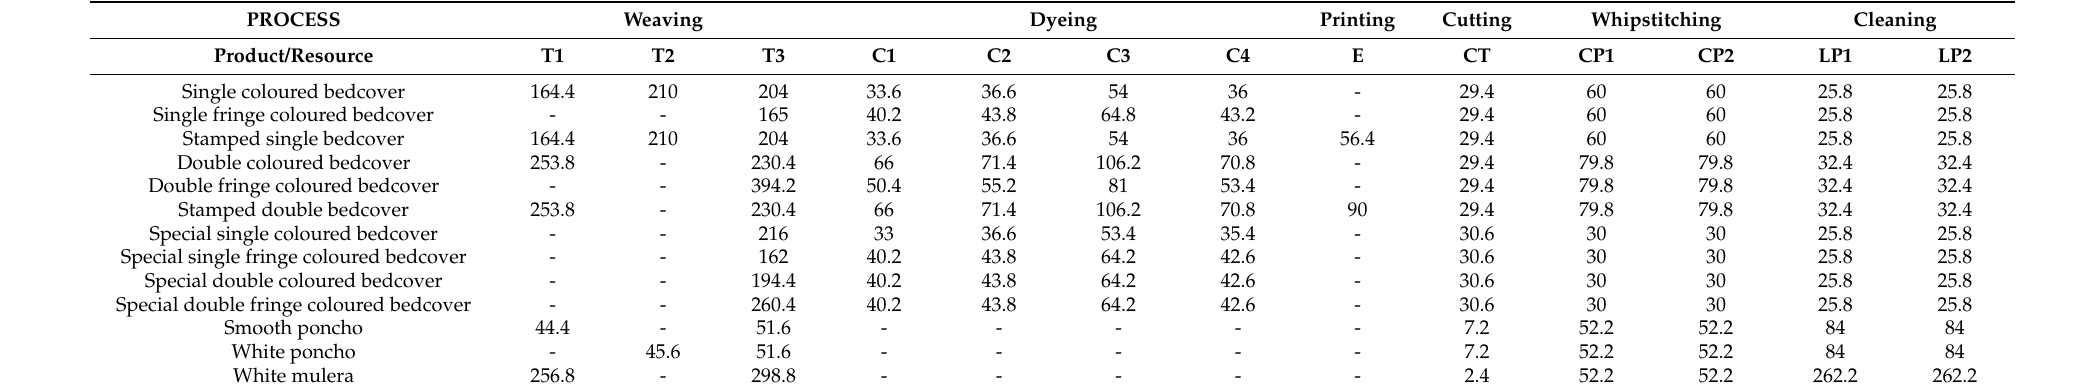
Table A1. Processing times for each product reference in each machine.